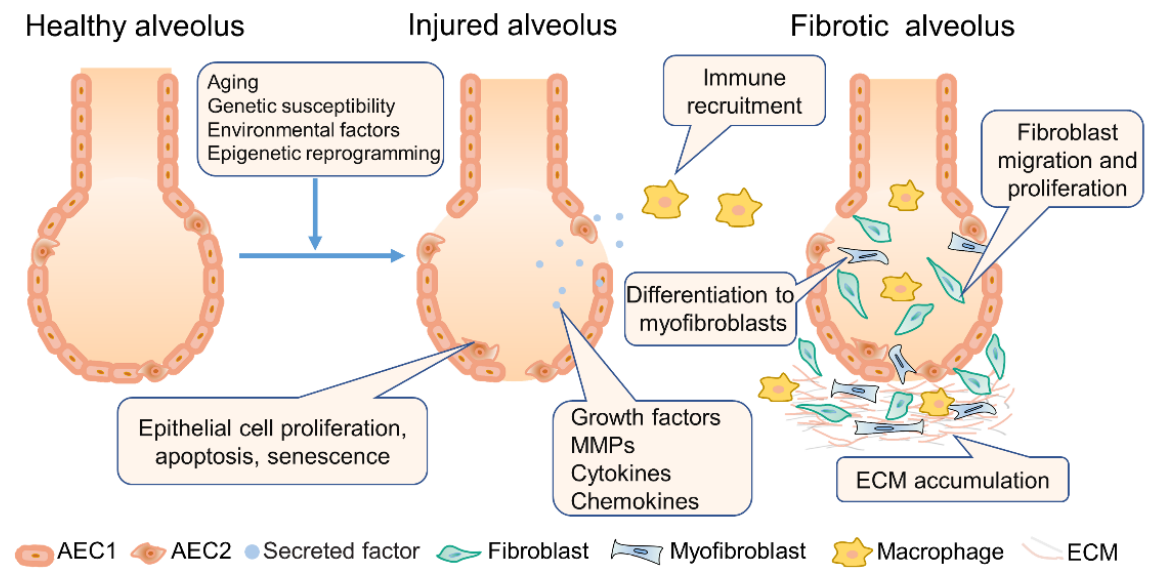
Figure 1. Pathophysiology of IPF.